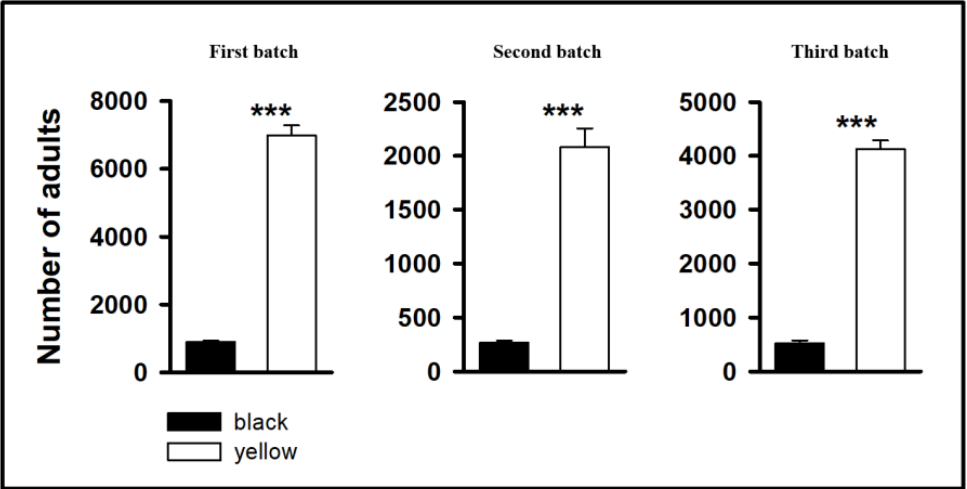
Figure 1. Numbers of yellow and black H. axyridis adults observed in nature in Heilongjiang province, China. Each bar depicts the mean (+SD) of different sampling years before the winter (September/October) in each of these years. Asterisks indicate significant differences between absolute numbers in each year ( t -test, *** p ≤ 0.001).